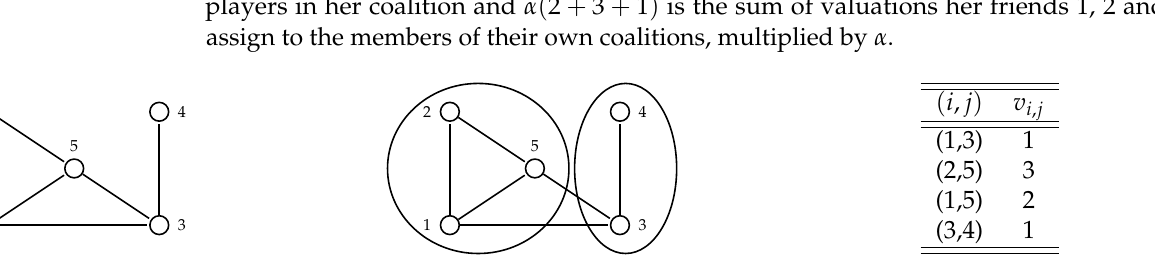
Figure 1. A social network G , a coalition structure C and the non-null valuations v i , j